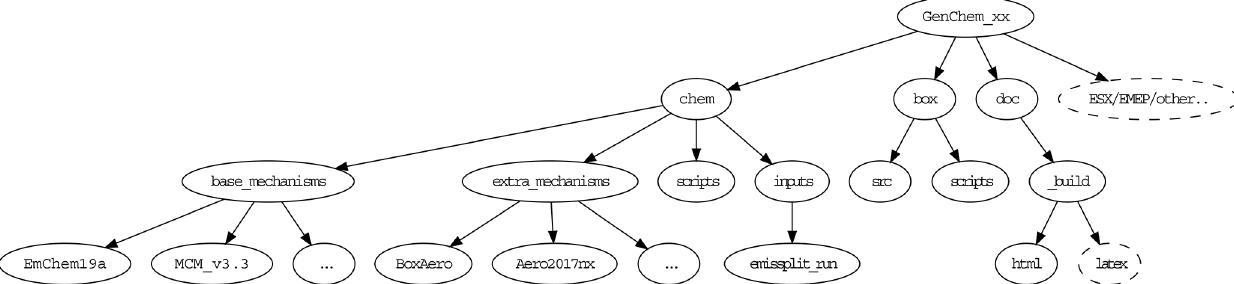
Figure 2. Directory structure of GenChem’s chem and box directories. The dashed “ESX/EMEP/other” directory indicates the possible placement of future EMEP, ESX or other model directories in this